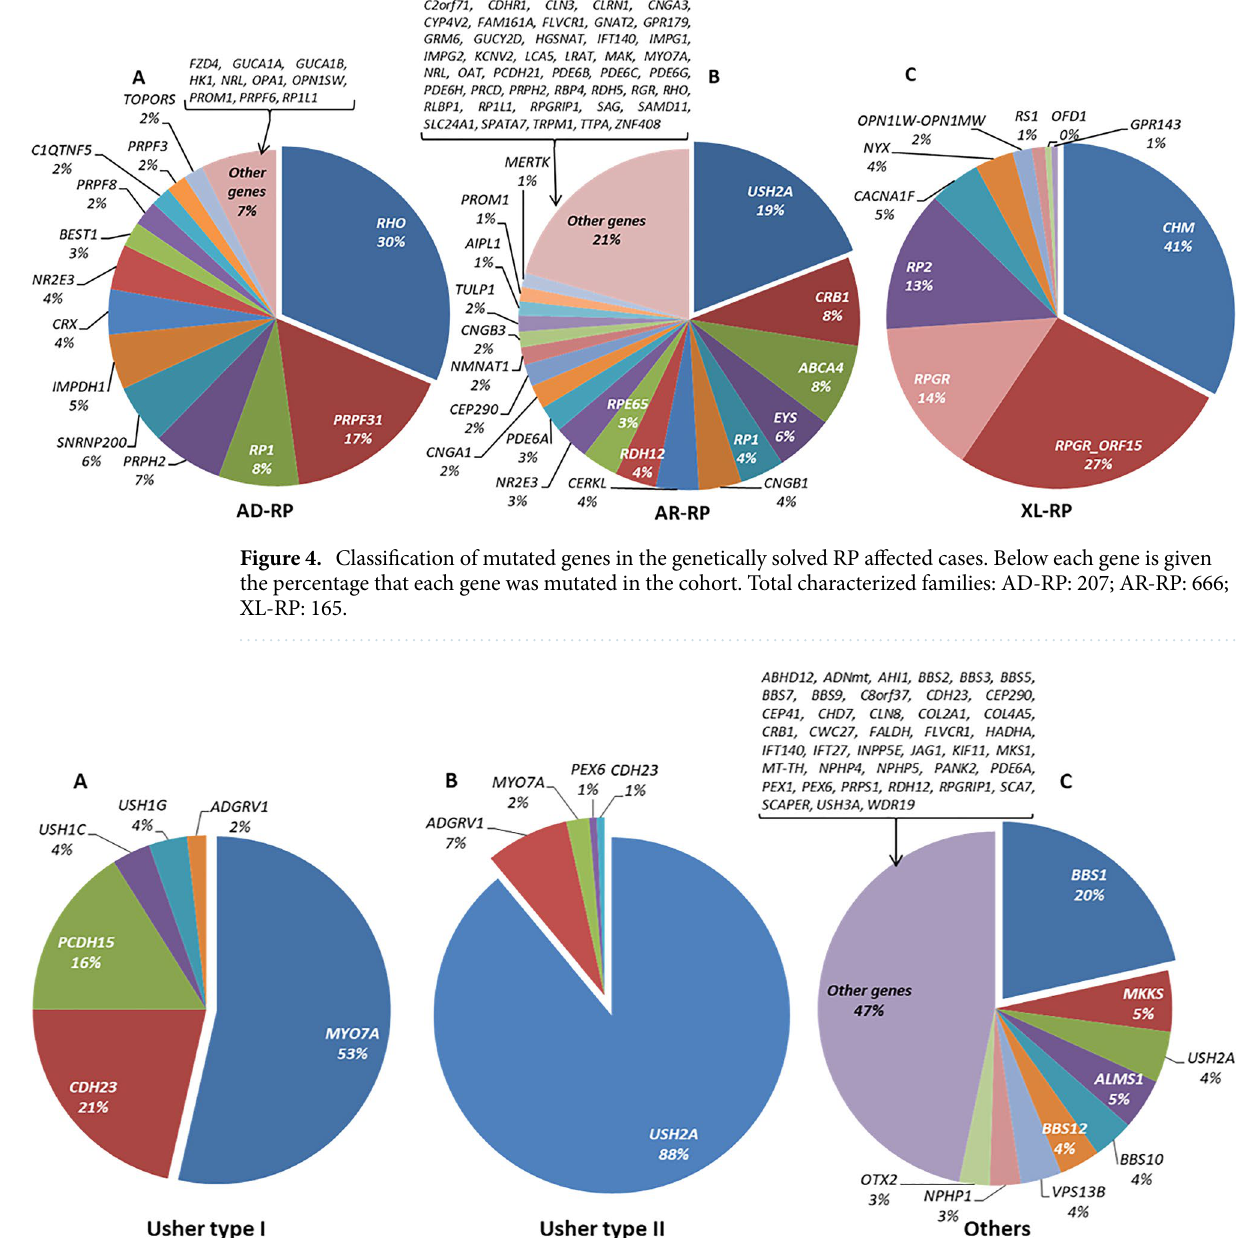
Figure 5. Classification of mutated genes in the genetically solved syndromic IRD affected cases. Below each gene is given the percentage that each gene was mutated in the cohort. Total characterized families: Usher I: 56; Usher II: 145; Others (including atypical Usher):